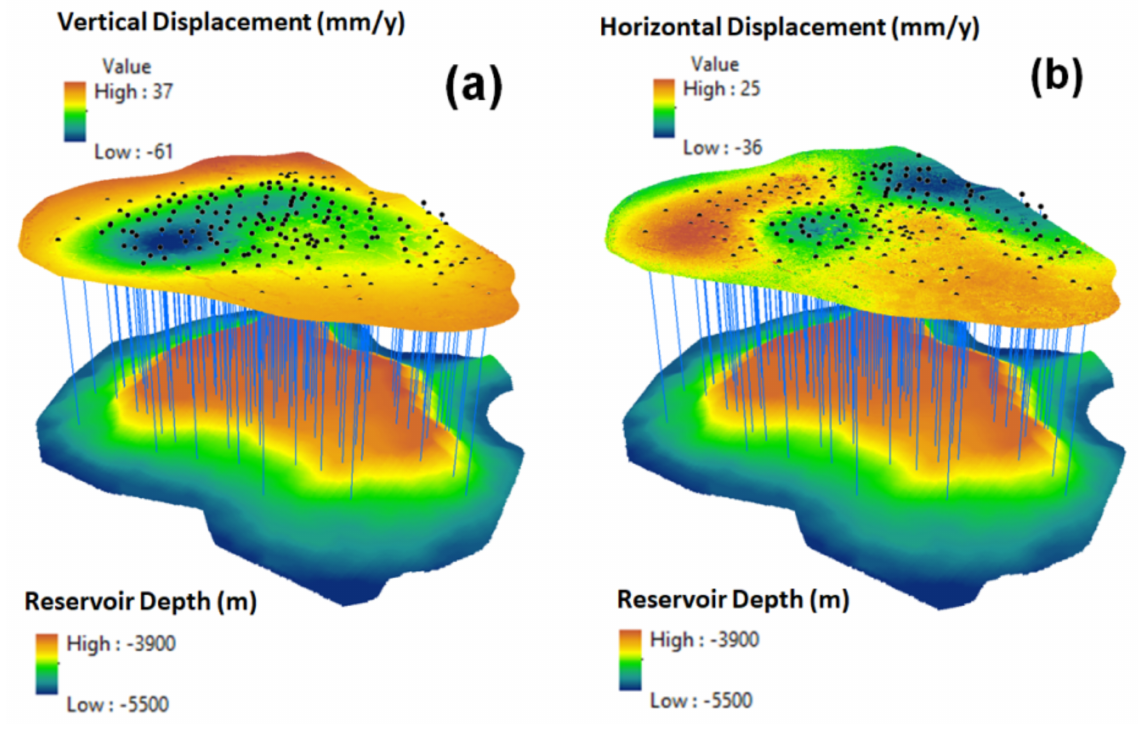
Figure 17. 3D models of: ( a ) vertical displacement velocity and reservoir depth; ( b ) horizontal displacement velocity and reservoir